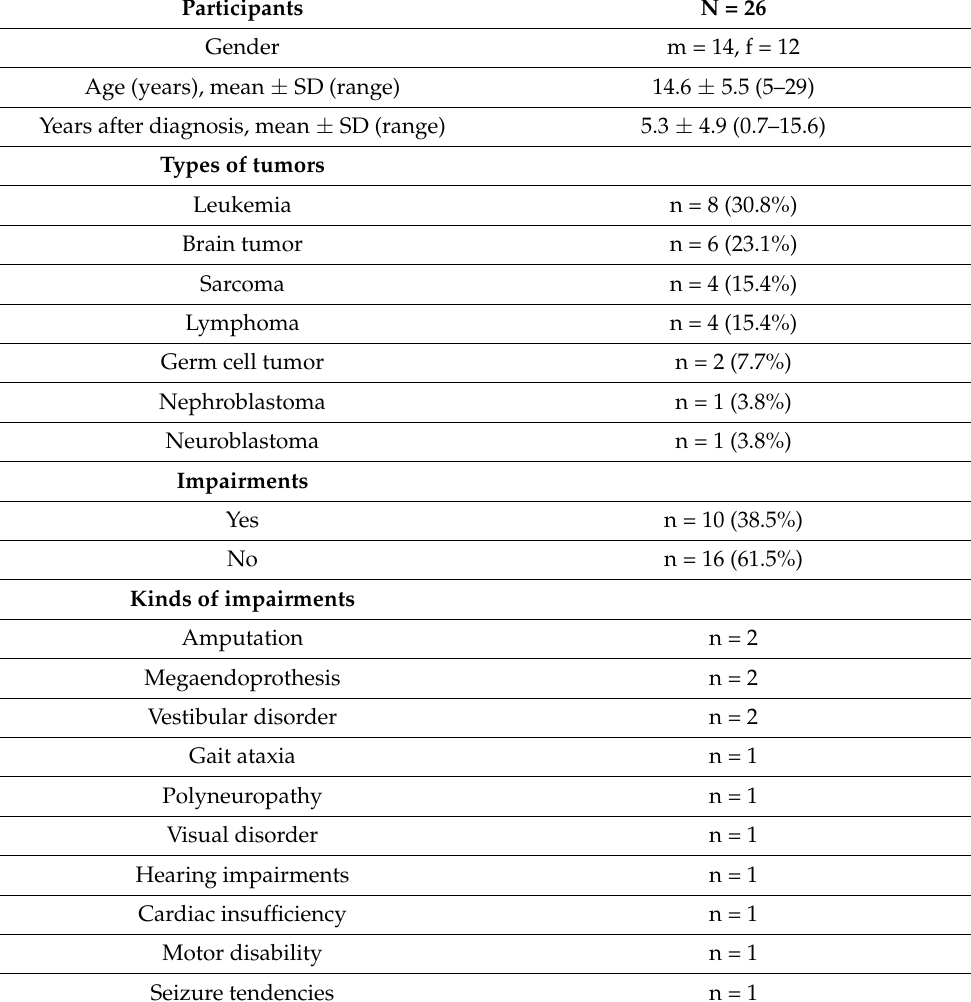
Table 1. Main demographic and clinical characteristics of the